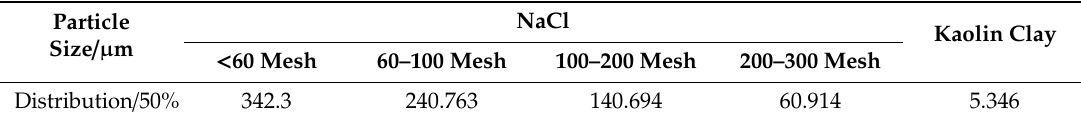
Table 3. Test results obtained using the laser particle-size analyser